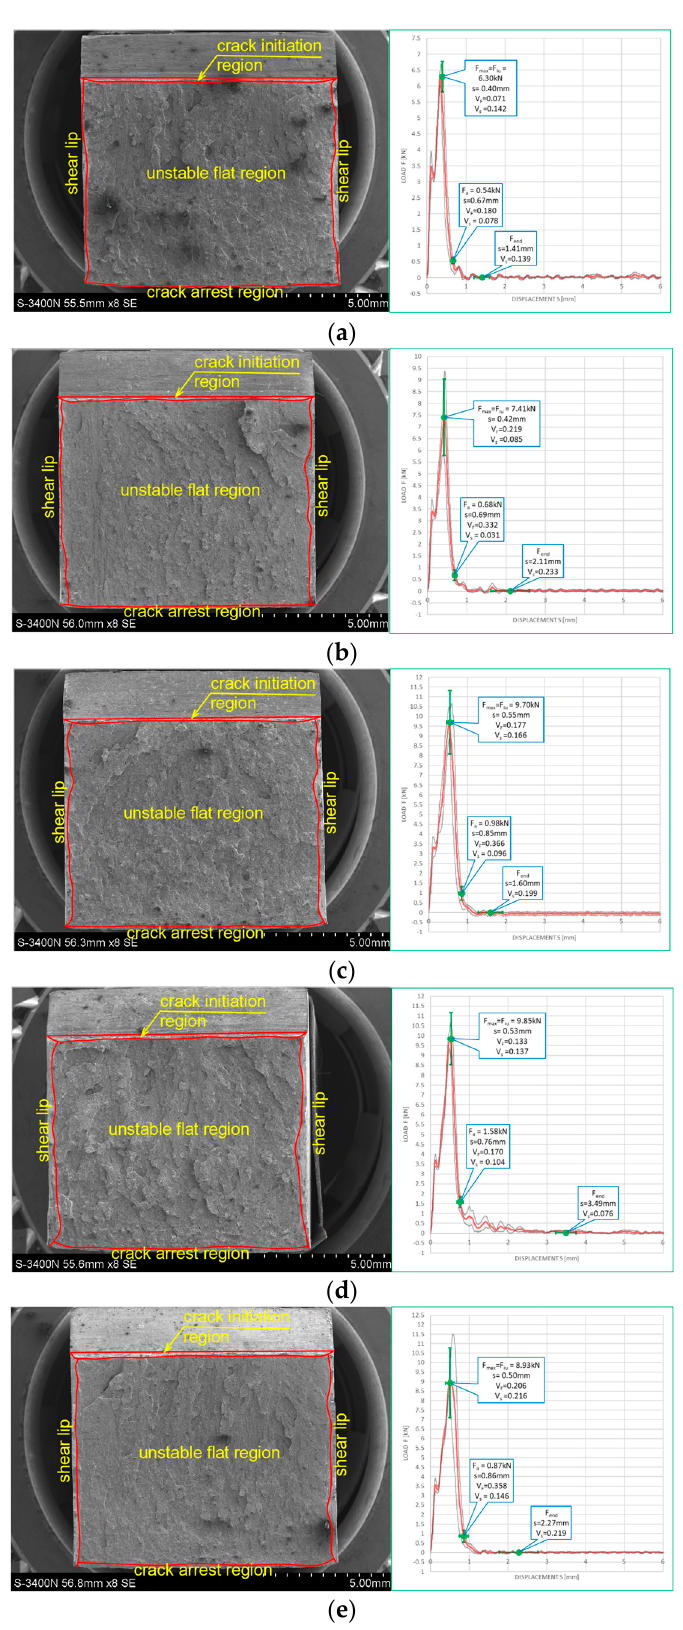
Figure 15. Morphology of the impact fractures obtained during the tests conducted at − 20 °C on the samples made of X20Cr13 steel—denotations follow the key listed in Table 1. ( a ) 2 ( − 20) ; ( b ) 260 ( − 20) ; ( c ) 261 ( − 20) ; ( d ) 280 ( − 20) ; ( e ) 281 ( − 20) .